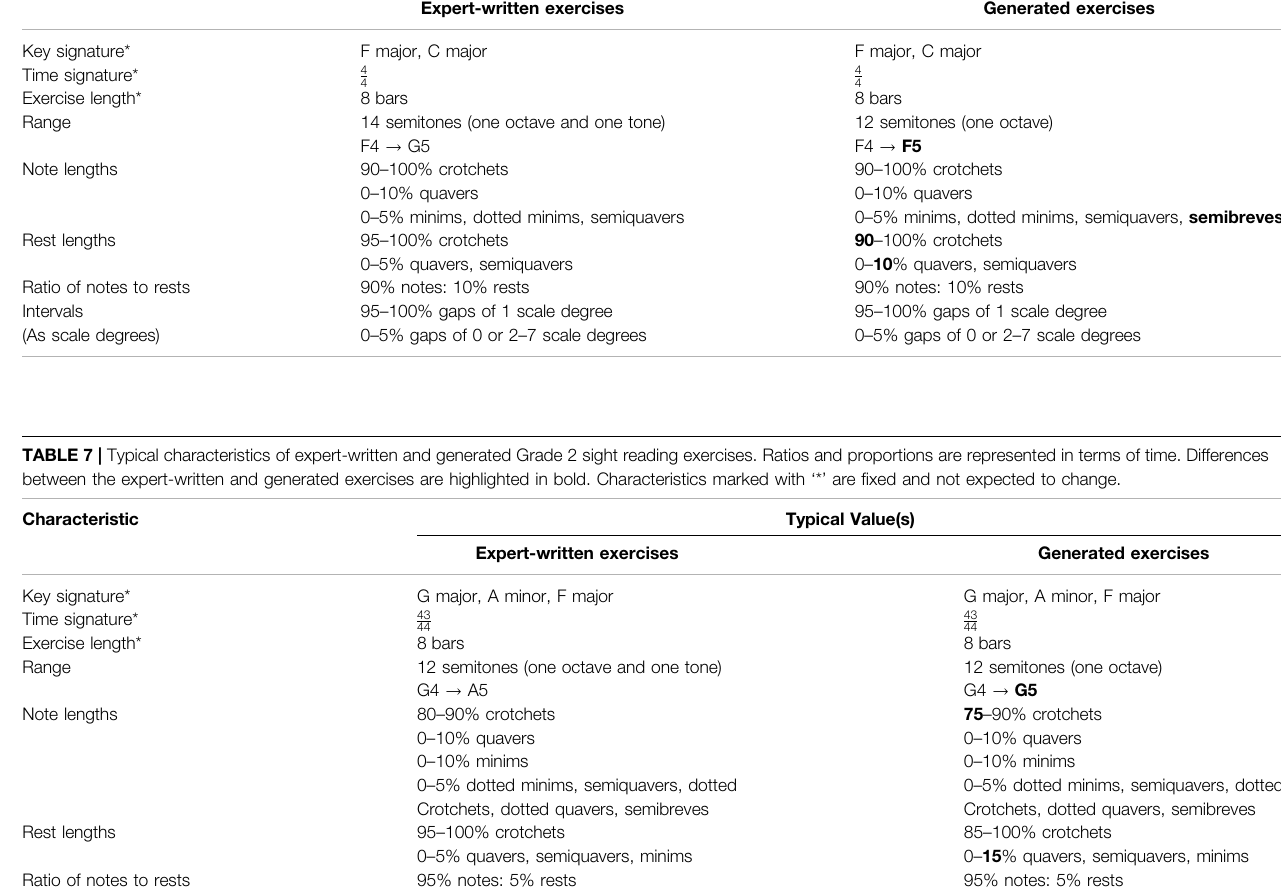
TABLE 6 | Typical characteristics of expert-written and generated Grade 1 sight reading exercises. Ratios and proportions are represented in terms of time. Differences between the expert-written and generated exercises are highlighted in bold. Characteristics marked with ‘ * ’ are fi xed and not expected to change. Characteristic